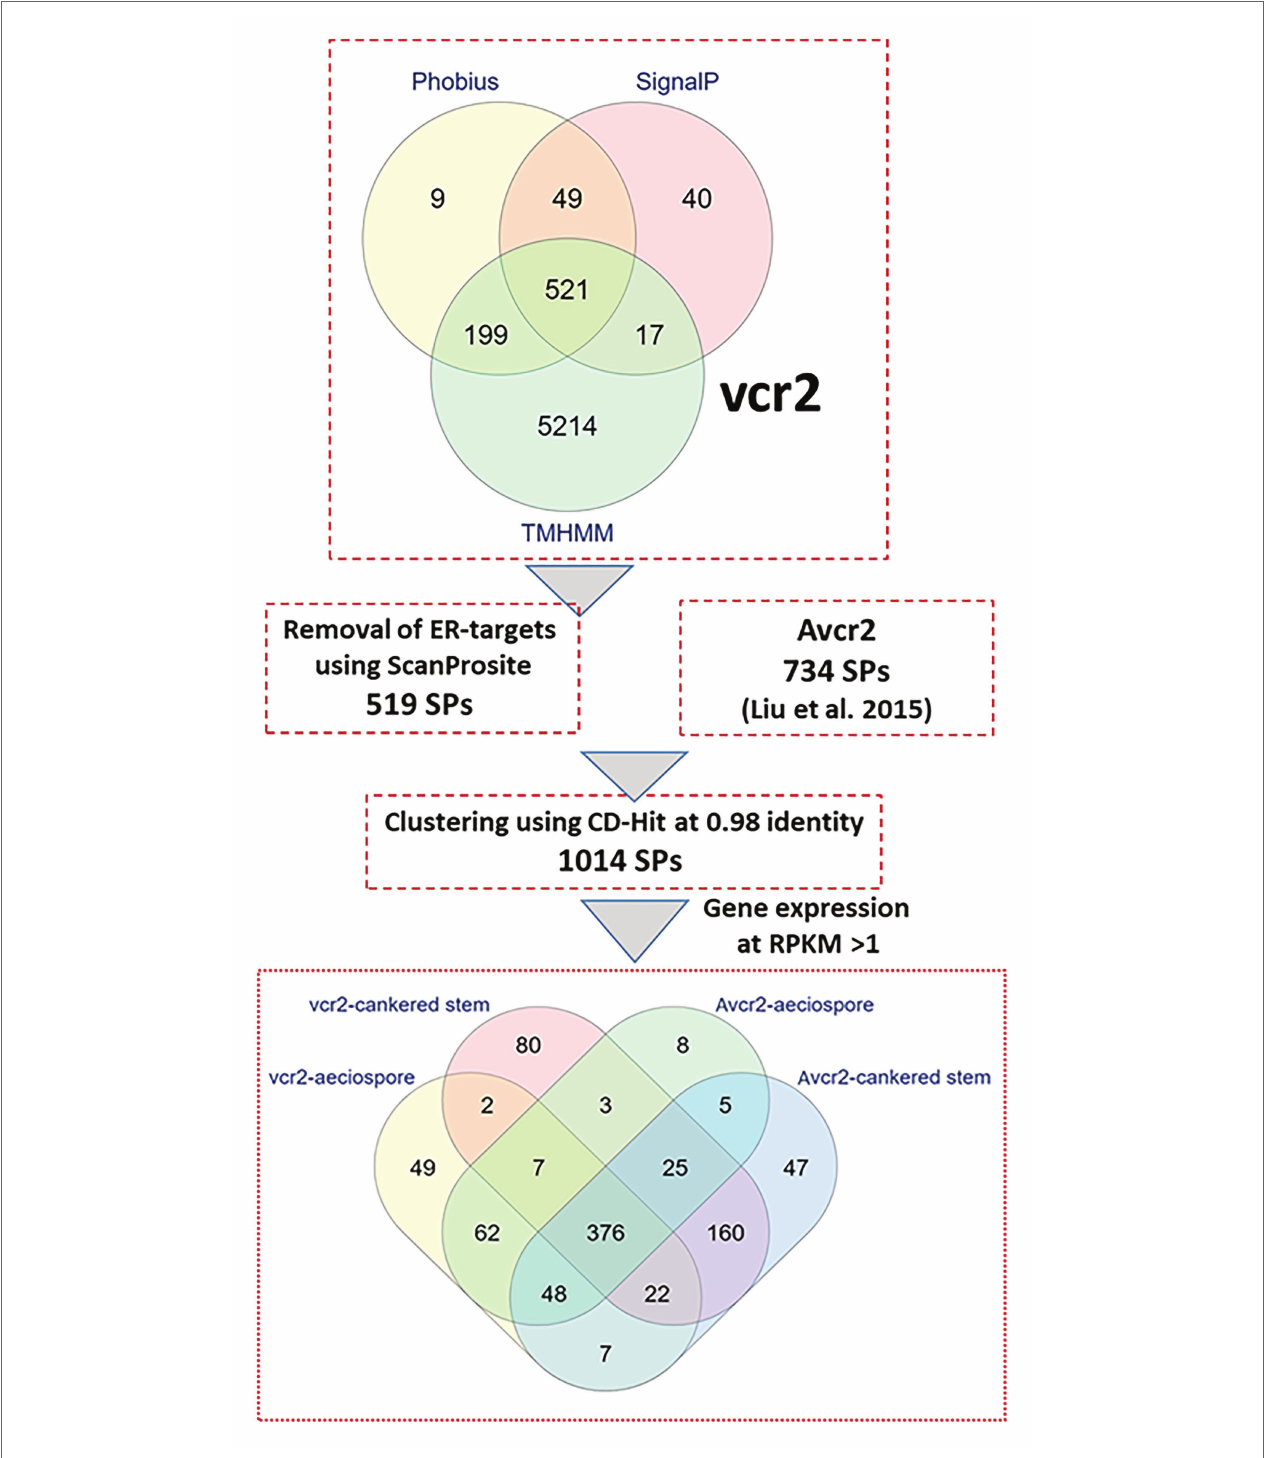
FIGURE 1 | In-silico secretome prediction and identification of pathotype-specific effectors using a combination of computational programs. Putative full-length proteins were used to predict presence of signal peptides by using SignalP-v5.0 and Phobius. Proteins with transmembrane (TM) domains were removed by using TMHMM-v2.0 and Phobius. Proteins targeted to endoplasmic reticulum (ER) were removed by using ScanProsite. Cri secreted proteins from vcr2 and Avcr2 pathotypes were clustered by using CD-Hit. Within the Cri secretome, pathotype-specific effectors and those exclusively expressed in cankered host tissues were determined by mapping RNA-seq reads with a threshold of FPKM >1. The Venn diagram at bottom showing number of unique and shared proteins identified in Cri vcr2 and Avcr2